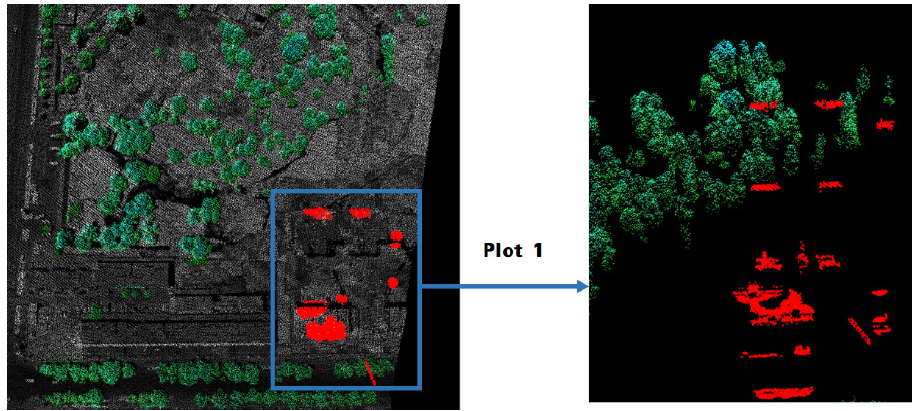
Figure 7. Tree point extraction results of the airborne LiDAR data. Most trees in the study area are well extracted (green points). Street shrubs with small, flat canopies are more likely missed (orange points). Large balconies and facades of tall buildings are the main components of mis-extractions (red points). Only two representative plots were selected for type I error and type II error, respectively.